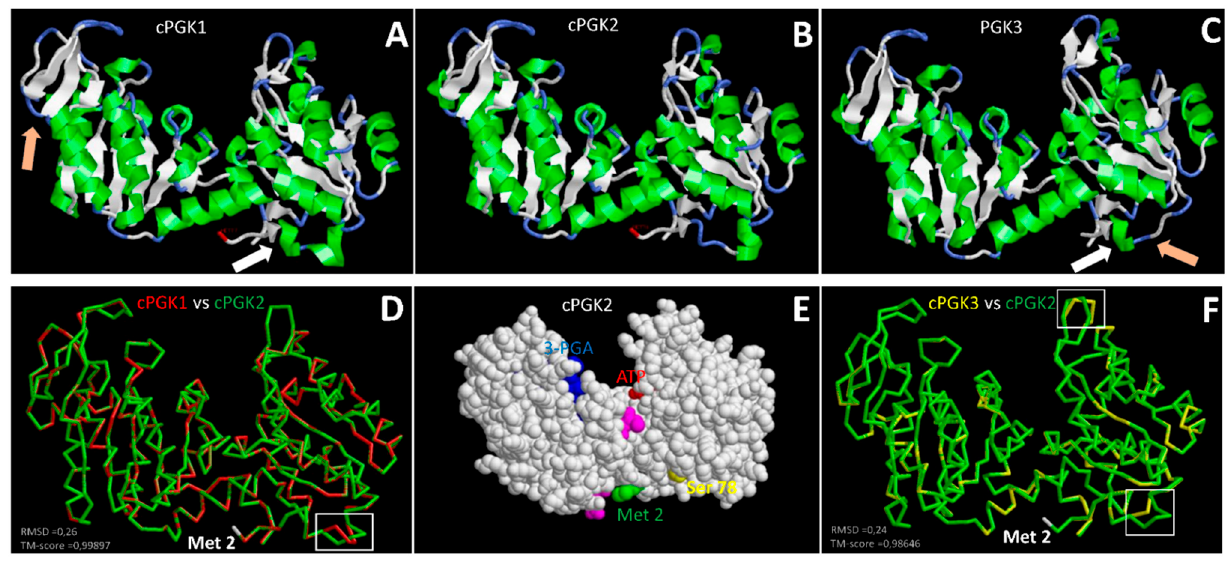
Figure 3. Predicted 3D structures and comparison of Arabidopsis thaliana phosphoglycerate kinases (PGK) reveal a high homology between chloroplastic and cytosolic PGKs isoforms. ( A – C ) Ribbon structures of the Arabidopsis cPGK1, cPGK2, and PGK3 enzymes obtained on Swiss model (https://swissmodel.expasy.org/interactive accessed on 28 July 2021) using the bacillus PGK having a crystallized structure as template. In ( A – C ), green and white colours, respectively, show helices and sheets in cPGK1, cPGK2, and PGK3 ribbon diagrams. Taking cPGK2 as a reference for structure model comparison, orange arrows in cPGK1 and PGK3 point to absent helixes that are present in cPGK2, while white arrows points to helixes absent in cPGK2, but present in cPGK1 and PGK3. Superimposed backbones of cPGK2 (green) with cPGK1 (red) and PGK3 (yellow) in ( D , F ), respectively, using TM-align (https://zhanggroup.org/TM-align/ accessed on 29 July 2021): RMSD and TM score values that are parameters evaluating the structural homology of proteins are indicated in each pairwise comparison. The few depicted structural dissimilarities between the isoforms corresponding to non-superimposed parts of the compared proteins are white-boxed in ( D , F ). ( E ) Molecular surface of cPGK2 enzyme using Raswin software [37] Version 2721 where structural information showing, in blue and red colours, residues involved in 3-PGA and ADP binding site; green, pink, and yellow colours point, respectively, to methionine 2 (position 74 from methionine 1), the hinge region that links the 2 domains, and Serine 78, a candidate mutation involved in the Cvi ecotype resistance against Watermelon mosaic virus (WMV).